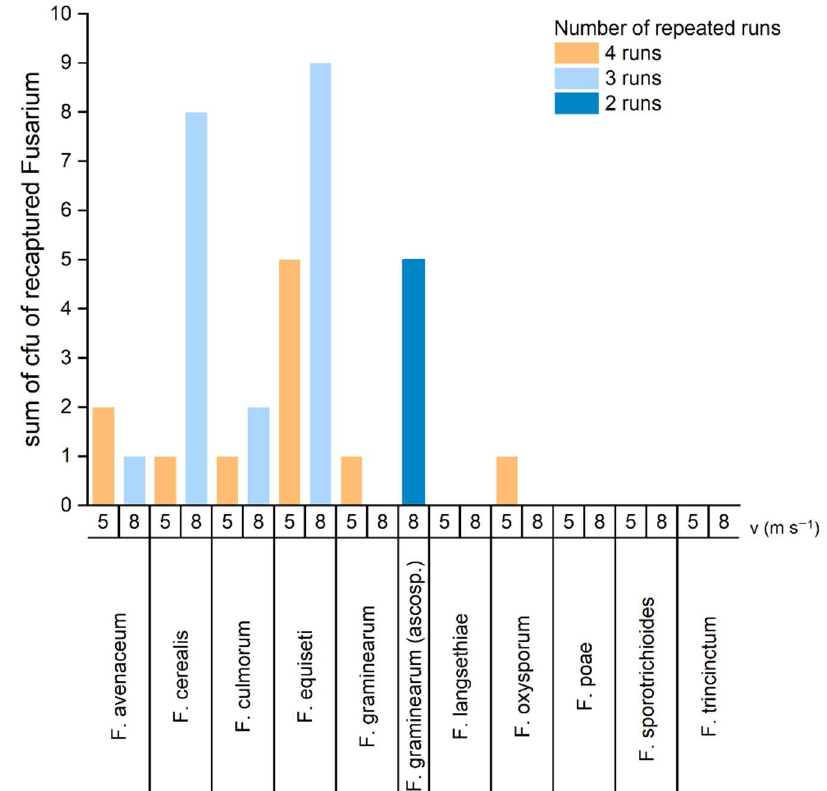
Figure 3. Recaptured Fusarium species after wind tunnel treatment (wtt) at 5 or 8 m s −1 . Ten Fusarium isolates grown on Synthetic Nutrient-Poor Agar (SNA) were placed in the wind tunnel for an hour. Spores were captured from the air with the help of the Air Sampler box (ASB). Each bar represents the sum of cfu of the related Fusarium species caught over the experimental duration. Four replicate runs were performed for the wtt at 5 m s −1 and three replicate runs for 8 m s −1 . F. graminearum ascospores wtt were only measured for 8 m s −1 in two repetitive runs.